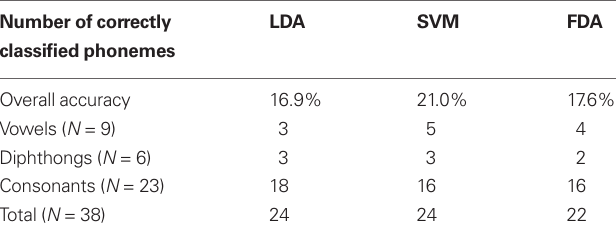
Table 3 | Summary of performance for each classification